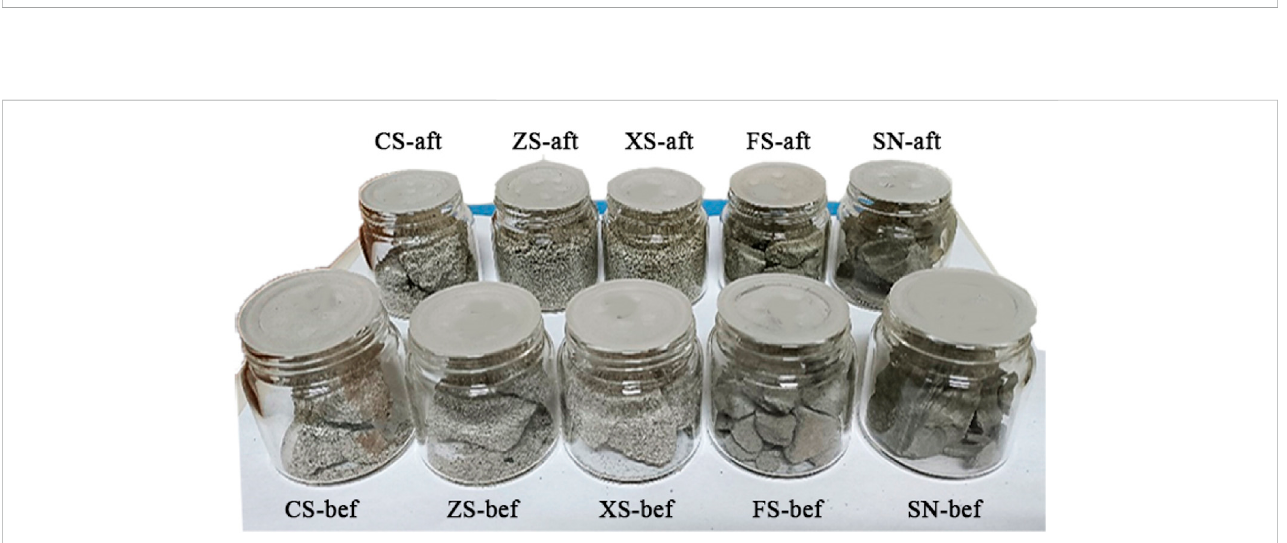
FIGURE 2 Imagesofsamplesusedinthispaper.CS-bef,ZS-bef,XS-bef,FS-bef,andSN-befrepresentthesamplesbeforethegeochemicalreaction;CS-aft,ZS-aft, XS-aft, FS-aft, and SN-aft represent the samples after the geochemical